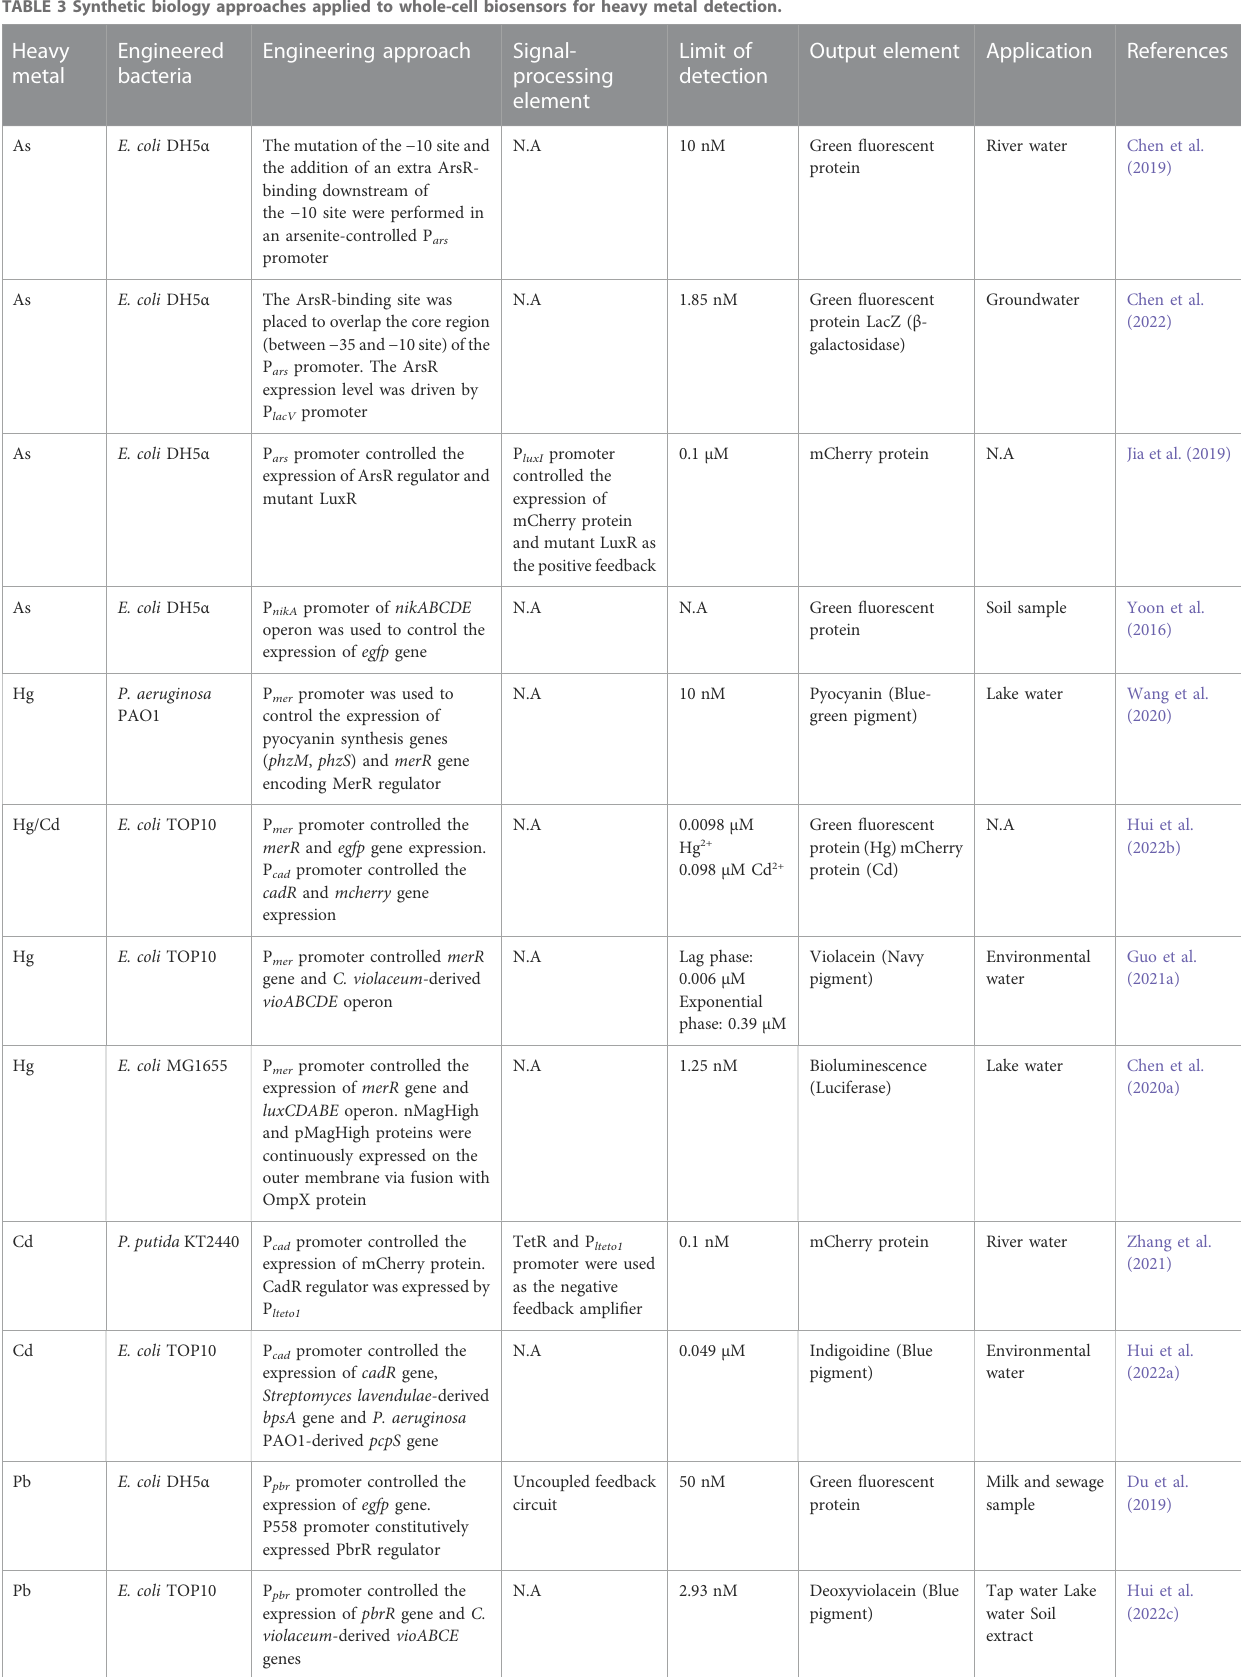
TABLE 3 Synthetic biology approaches applied to whole-cell biosensors for heavy metal detection. Heavy